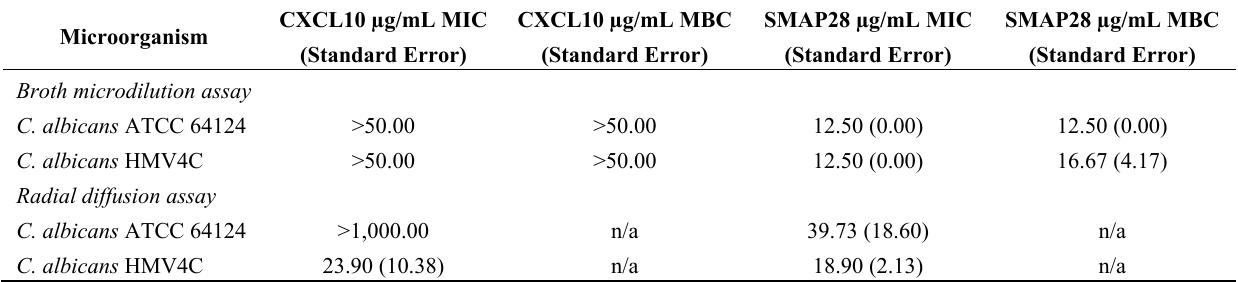
Table 4. Broth microdilution and radial diffusion assays showing the minimal inhibitory concentration (MIC) and the minimal bactericidal concentration (MBC) of CXCL10